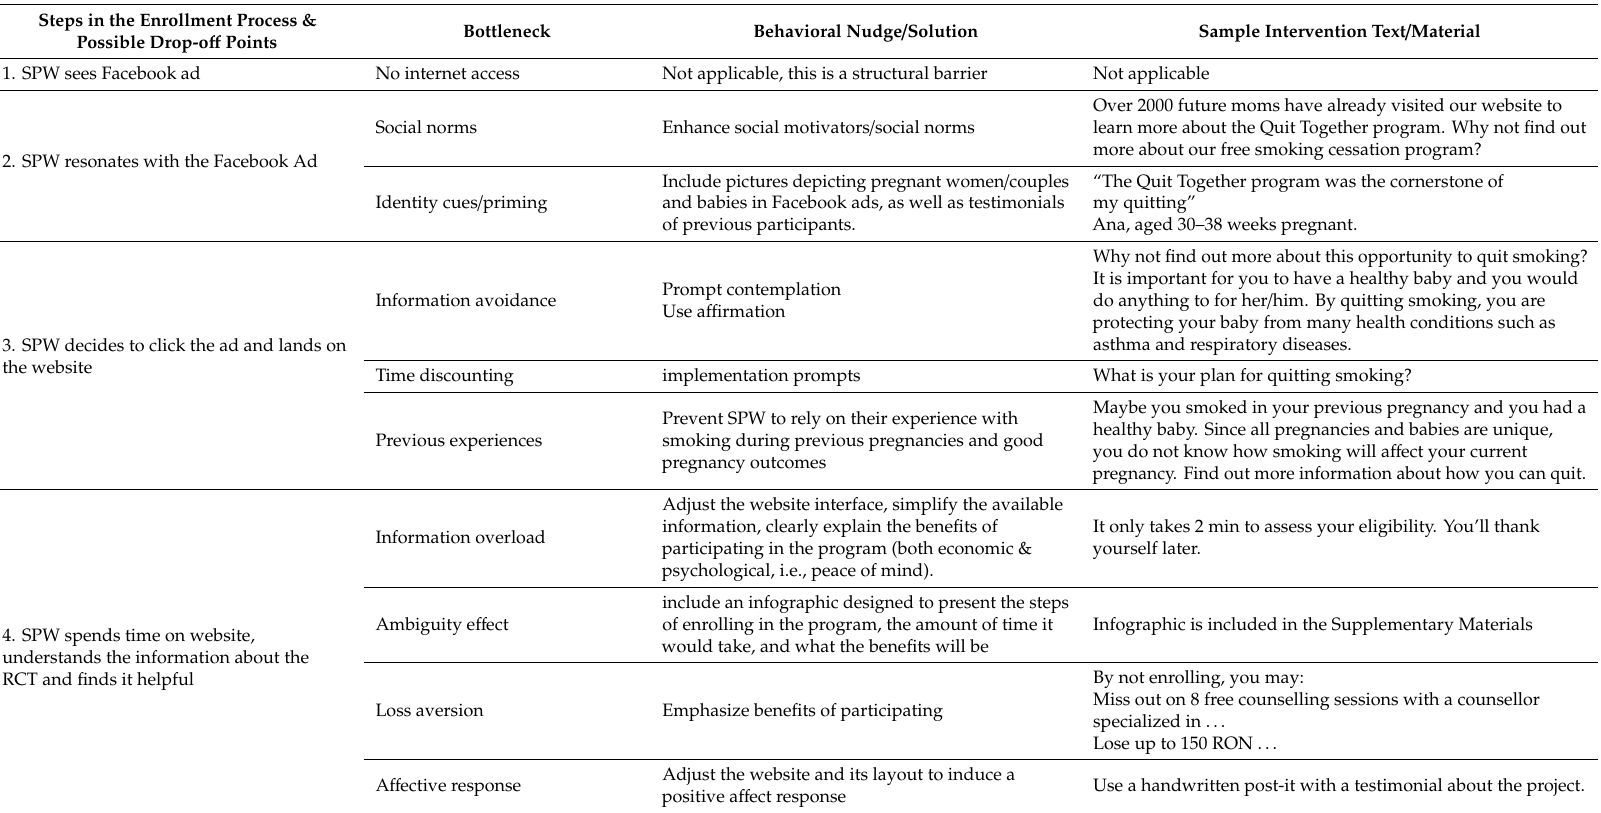
Table 1. Process map for smoker pregnant woman (SPW) enrollment in the QT RCT, possible drop-o ff points / bottlenecks, behavioral nudges, and sample intervention texts /